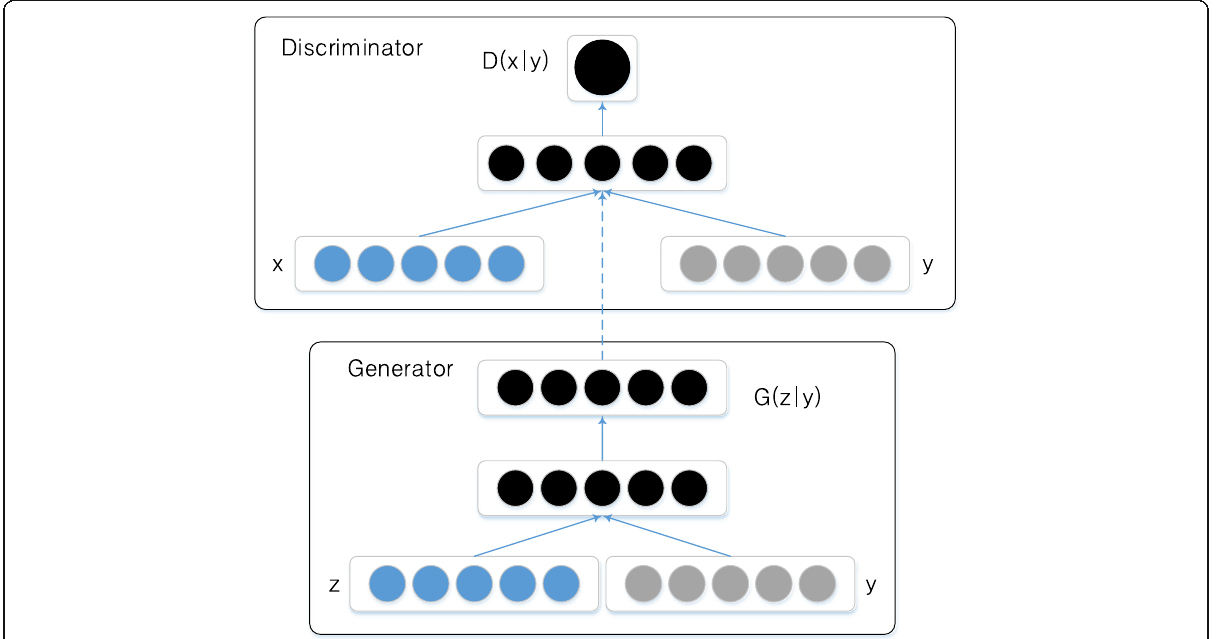
Fig. 1 The structure of speech enhancement conditional GAN. There are a positive pair (noisy speech and clean speech) and a negative pair (noisy speech and generate speech), then the discriminator is to distinguish between the two